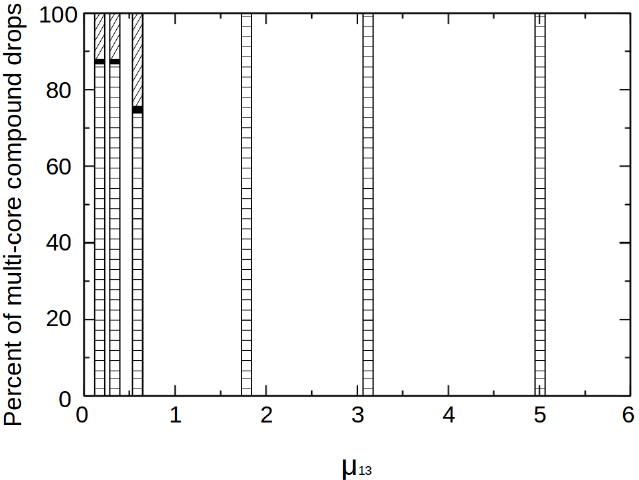
Figure 10. Percent of multi-core compound drops formed versus inner-to-outer viscosity ratio. The horizontal and slant lines depicted in this plot correspond to 1-core and 2-core compound drops formation